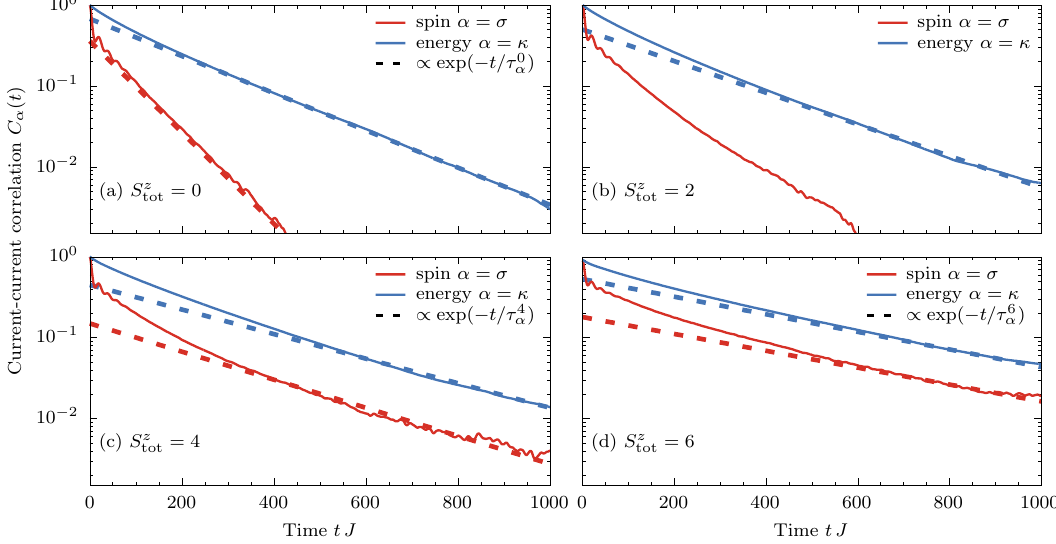
Figure 2: Correlation functions C α ( t ) in sectors with various S z (a) depict exponential fits for α = j σ , j κ at s = S z